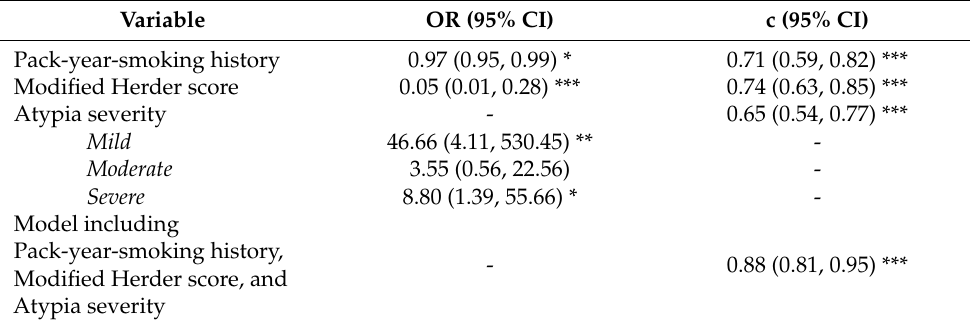
Table 3. Logistic regression predicting final diagnosis with area under the